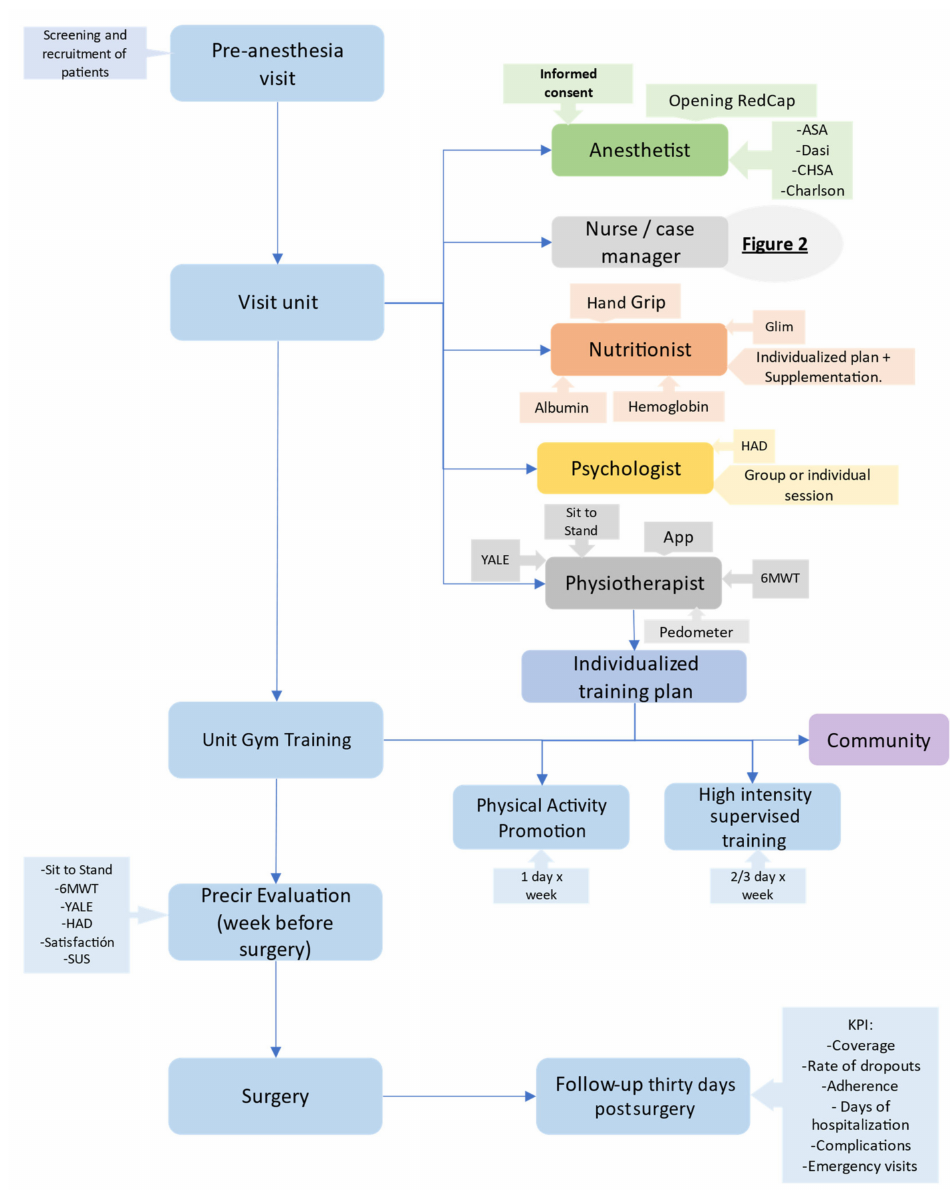
Figure 1. General circuit of the PreHab